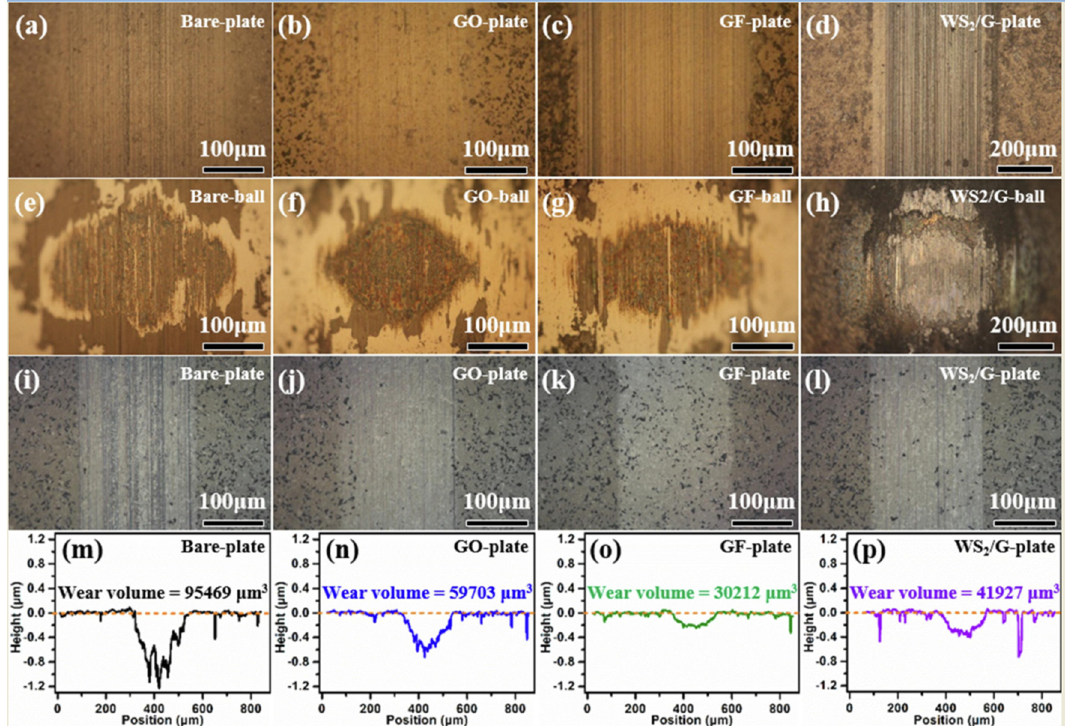
Figure 6. The optical images showing: ( a – d ) The surface wear morphologies of the graphite plates and ( e – h ) the corresponding counter facing bearing steel balls after lubrication by the 2D lubricant additives for 12,000 cycles of frictional test, ( i – l ) the surface wear morphologies of the graphite after lubrication by the 2D lubricant additives before the complete evaporation of the alcohol, ( m – p ) the corresponding wear depths and wear volumes of the graphite. Reproduced with permission from